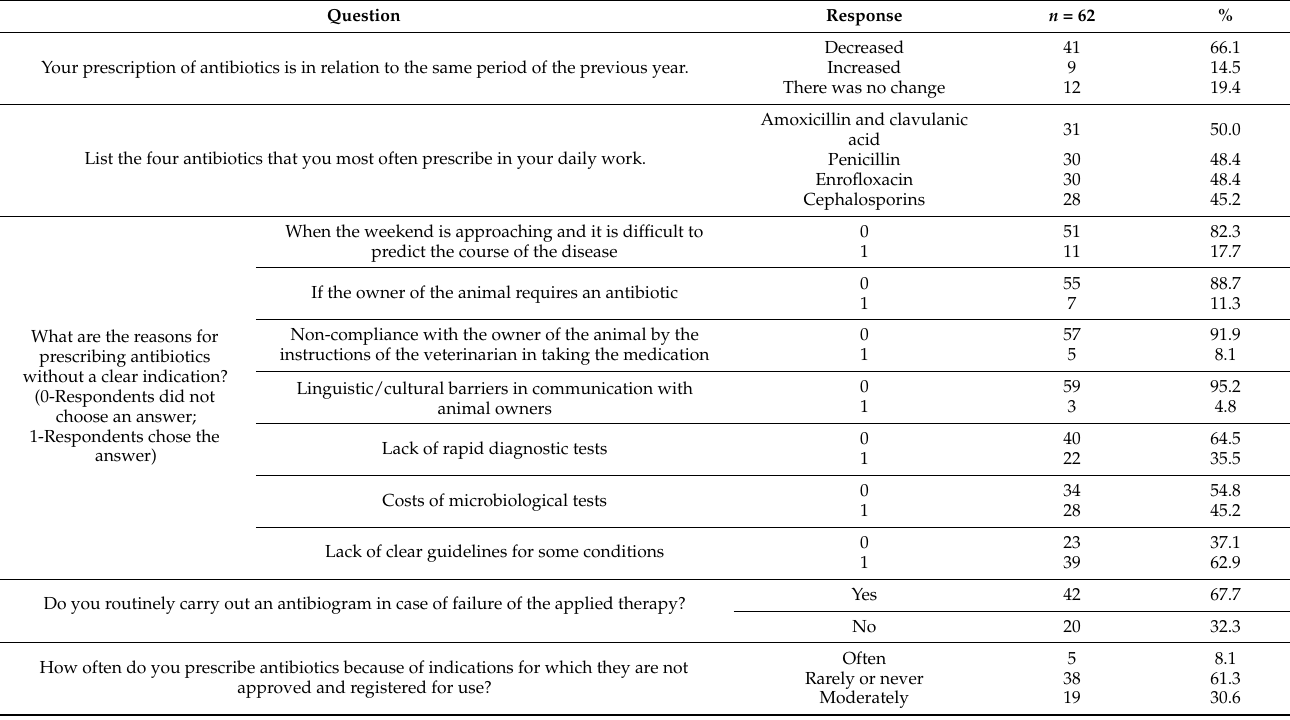
Table 4. Antibiotic prescribing